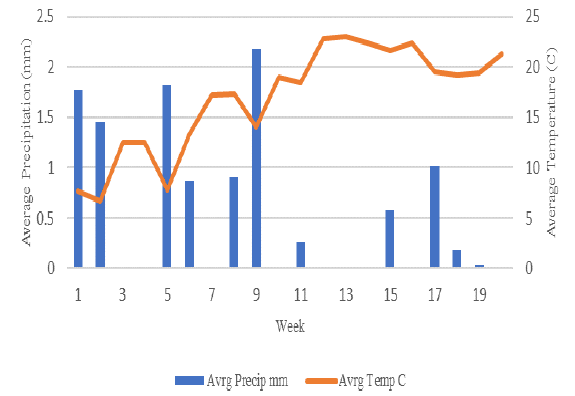
Figure 8. Precipitation and Temperature during the 2017 growing season provided by U.S. Bureau of Reclamation Agrimet weather station.